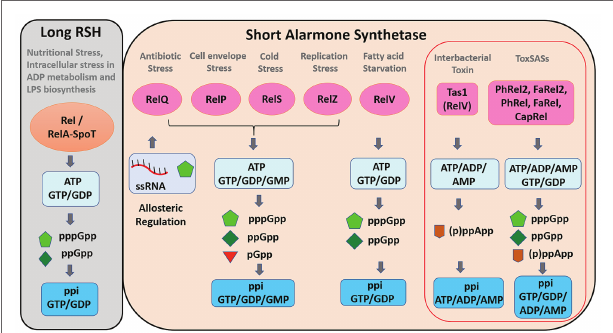
FIGURE 2 | Functions of long RSH and short alarmone synthetase. Long RSH, Rel/RelA-SpoT, synthesize pppGpp and ppGpp using GTP/GDP as substrates during nutritional stress. SAS protein expression is induced by various stress signals. SAS Rels synthesize pGpp in addition to pppGpp and ppGpp using GTP/GDP/GMP as substrates. pppGpp and ssRNA bind to RelQ and mediate the allosteric regulation. The pppGpp synthesis activity of RelZ is also inhibited by RNA and pppGpp. Tas1 synthesize (p)ppApp using ATP/ADP/AMP as substrates. ToxSASs (not Tas1) synthesize both (p)ppGpp and (p)ppApp. ToxSASs are represented within red outlined